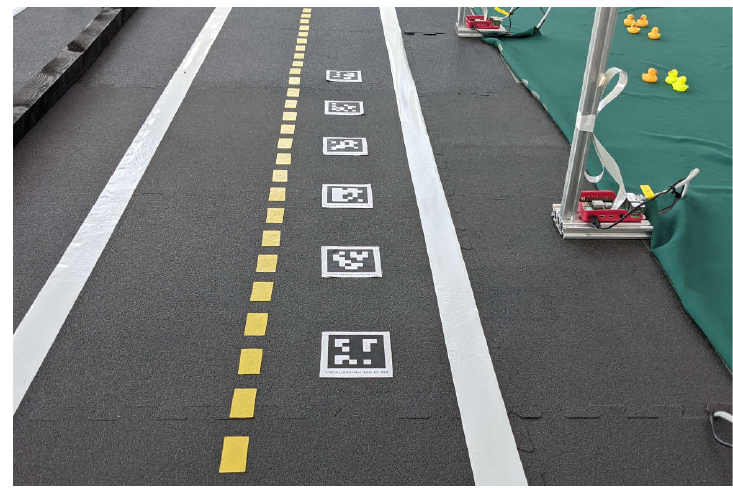
Figure 6. Markers’ locations for auto-calibration in